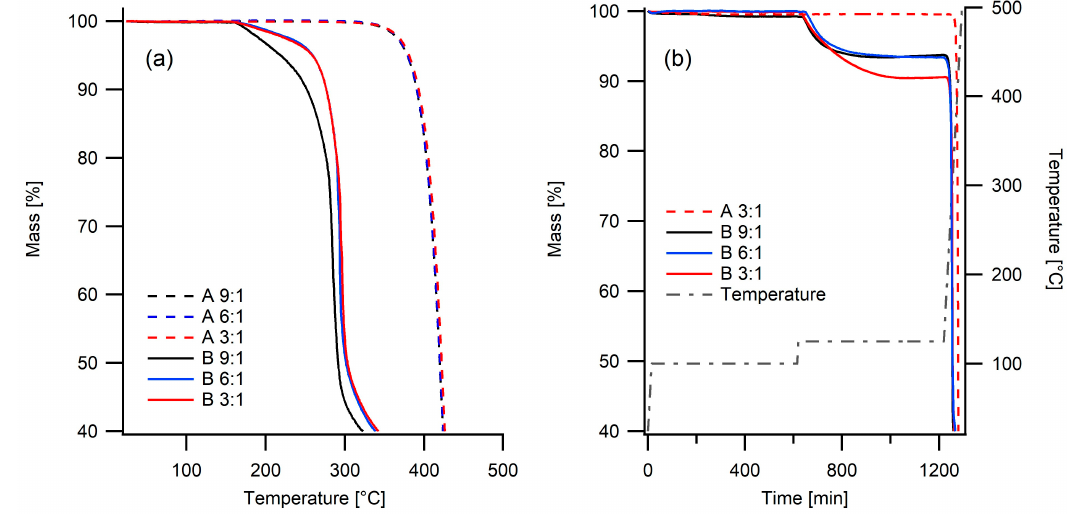
Figure 3. Dynamic ( a ) and isothermal ( b ) TGA heating traces of the PIL el .